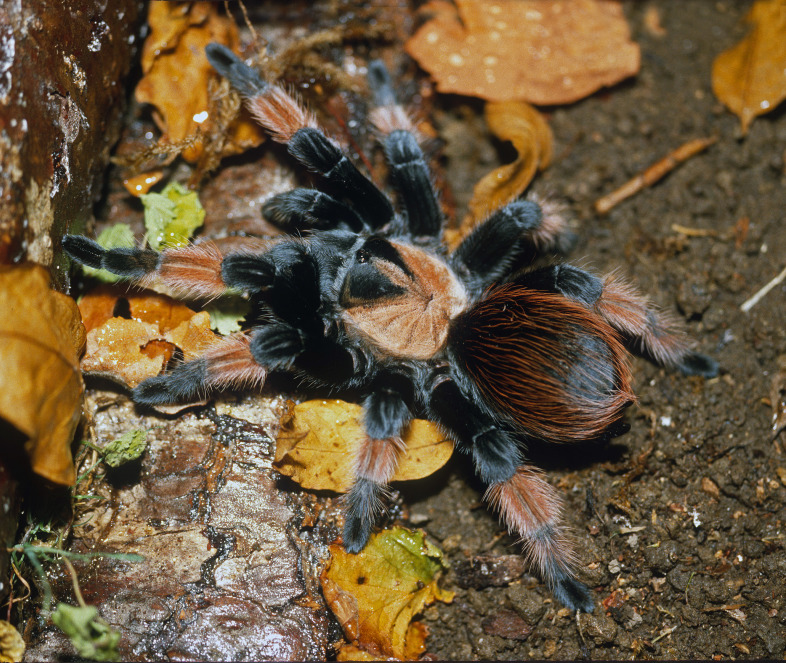
Brachypelma
emilia (White, 1856) female near San Blas, Nayarit state, Mexico. Photo: Rick C. West.